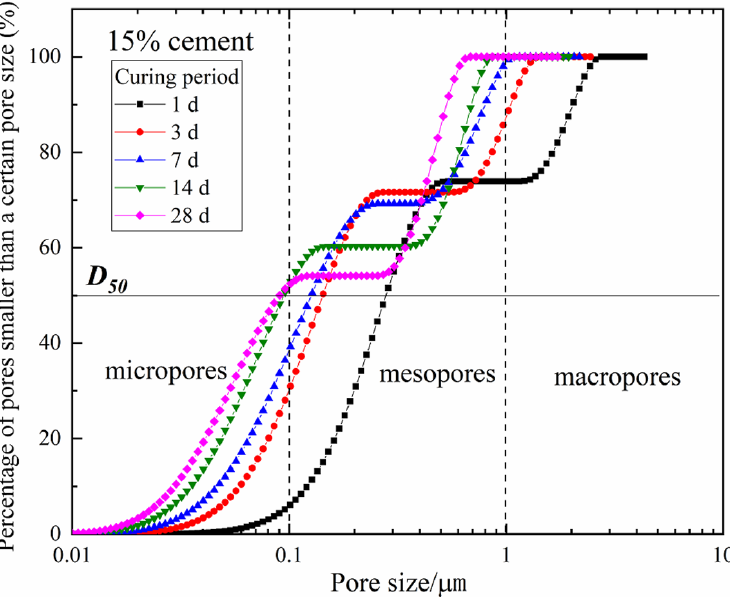
Figure 8. The cumulative pore size distribution curve of the specimen with 15% cement.